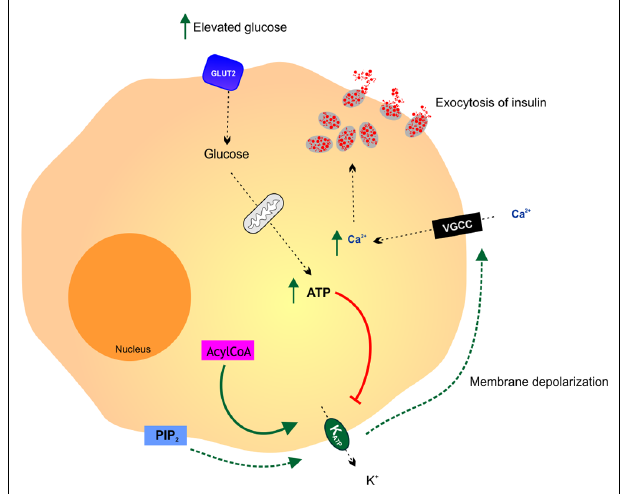
membrane depolarization, activation of voltage gated calcium channels (VGCC), free calcium entry and insulin release by exocytosis. It is thought that various additional effectors including phosphatidylinositol-4,5- bisphosphate (PIP2) and acyl CoAs modulate the ATP sensitivity of the K ATP channel thereby affecting the coupling of pancreatic cell metabolism to insulin secretion. Adapted from Koster etal. (2005).